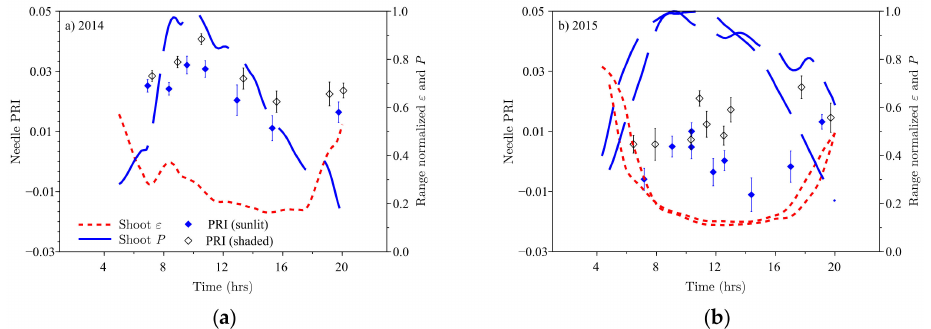
Figure 3. Diurnal variation in shaded (empty symbols) and sunlit (filled symbols) needle PRI (pooled data, left axes); and the photosynthetic assimilation P (dashed line) and the light use efficiency ε of sunlit shoots (dotted line, right axes). P and ε are normalized by their maximum daily values; ( a ) 2014; and ( b ) 2015. Error bars indicate 90% confidence limit for mean needle